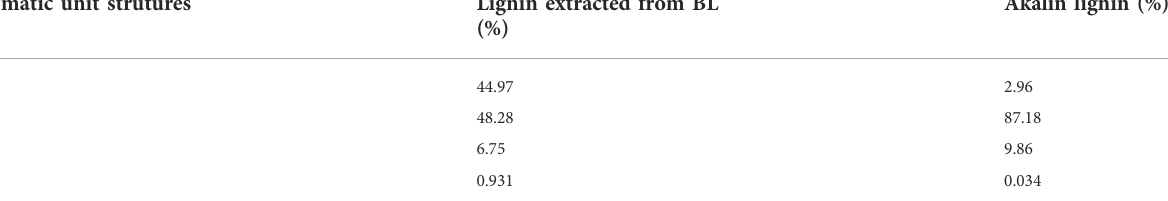
TABLE 3 Aromatic unit structures of lignin. Aromatic unit